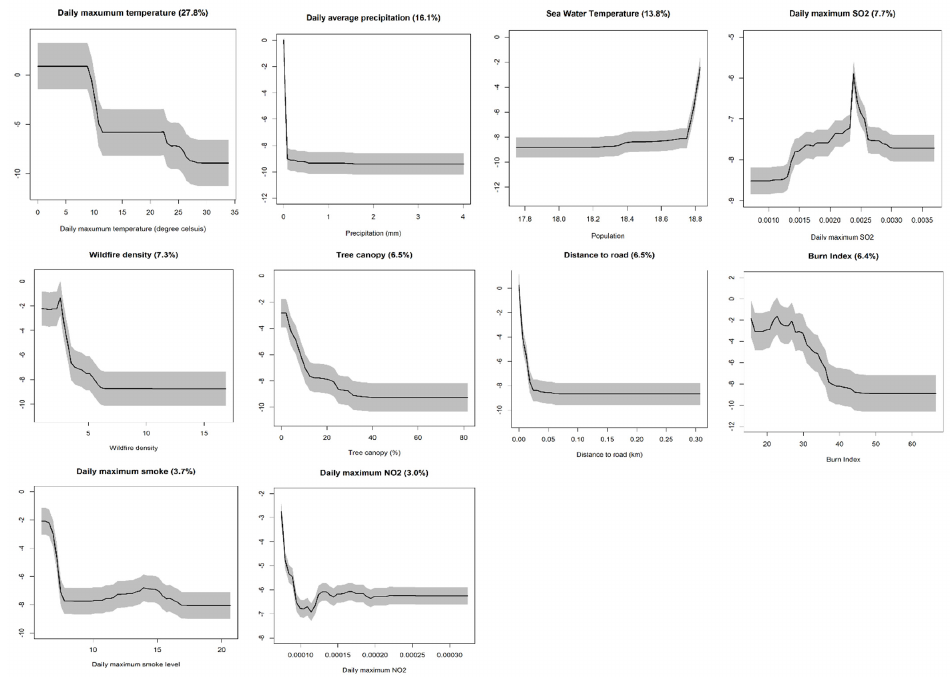
Figure 7. Partial dependency plots of covariates used in the RF model to estimate the spatial distribution of the mortality of the Common Murre. The gray shading area indicates the confidence intervals derived from the model iterations. We report the mean decrease accuracy for each of the variables in the parentheses.